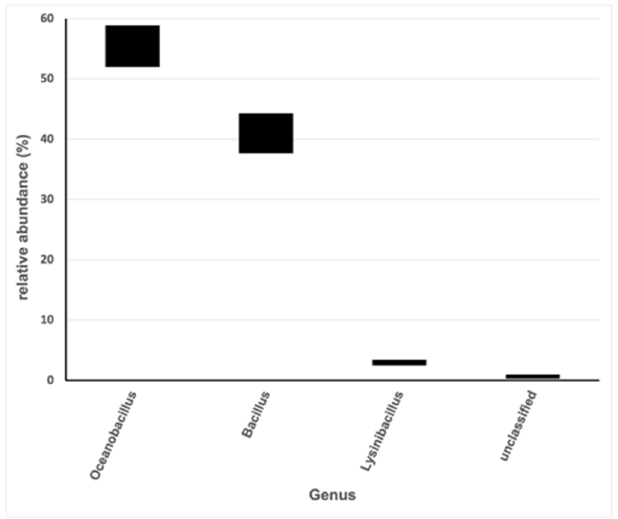
Figure 3. Relative abundance of genus represented in the pool of isolates from viable cells counting experiments. Bacterial diversity was assessed by 16S rDNA NGS analysis. The group “others” comprises low represented genus (<1% relative abundance). Bars represent ranges of abundance obtained by determinations made on two independent pooled samples.